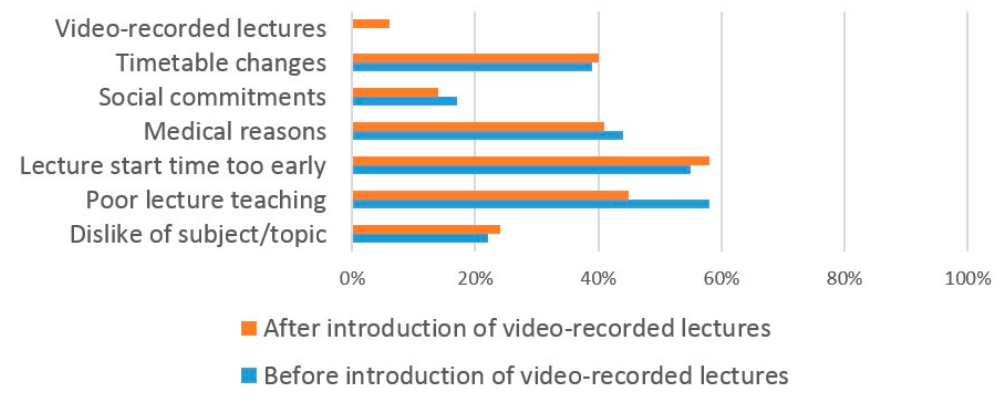
Figure 5. The reasons why dental students miss lectures.